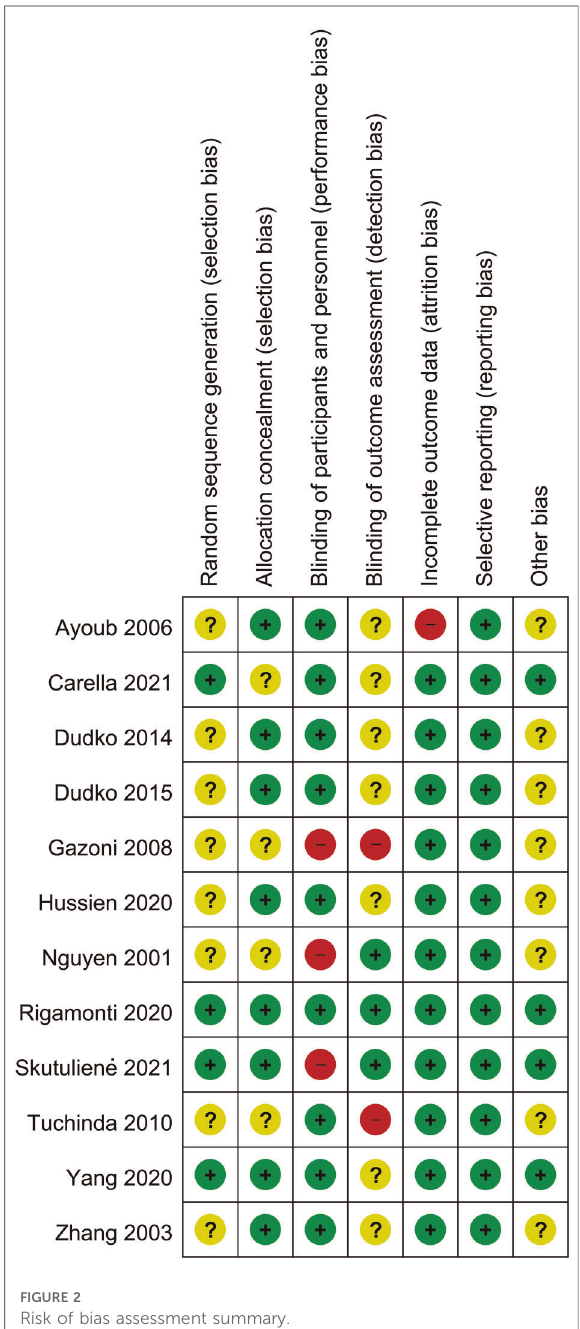
FIGURE 2 Risk of bias assessment